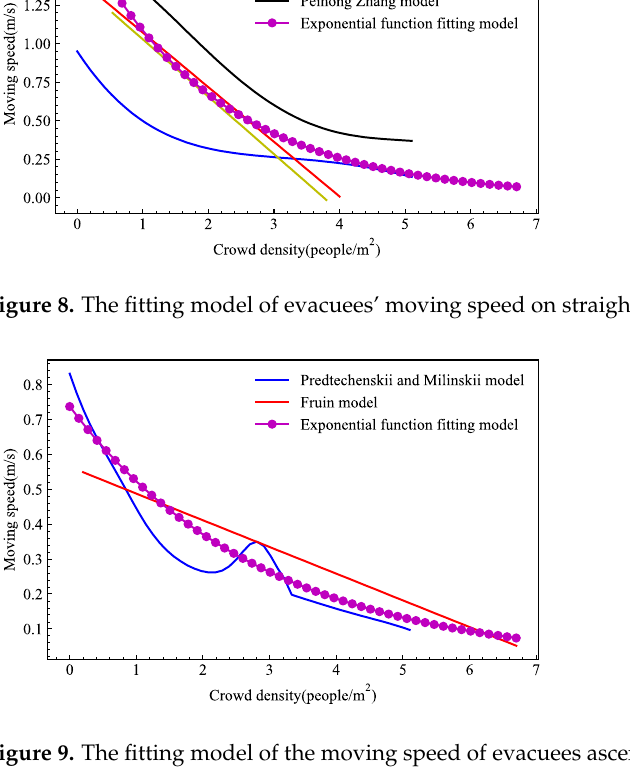
Table 4. Evacuee’s attributes and scope.